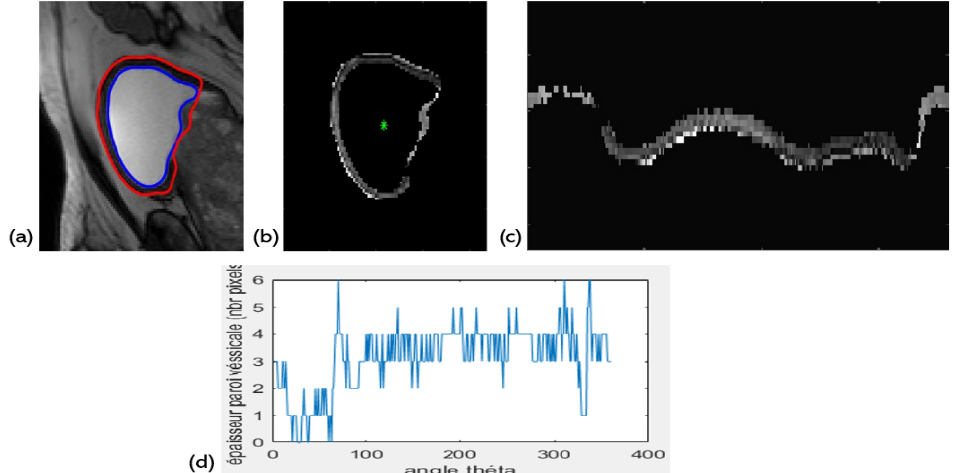
Figure 3. Exploration of the polar representation: ( a ) Level set bladder wall segmentation. ( b ) Bladder wall extraction in cartesian coordinates. ( c ) Switching to polar coordinates: θ angle on the x -axis, radius R on the y -axis. ( d ) The wall thickness as a function of the angle θ .